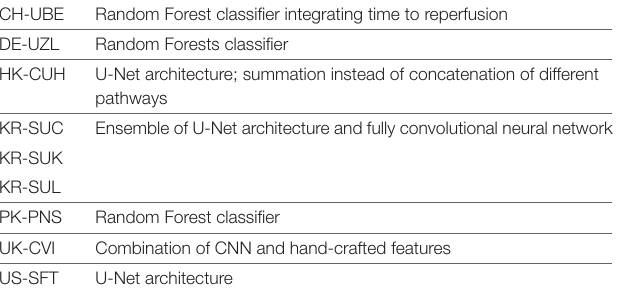
TABLE A2 | Overview of methods of participants of ISLES 2016. CH-UBE Random Forest classifier integrating time to reperfusion DE-UZL Random Forests classifier HK-CUH U-Net architecture; summation instead of concatenation of different